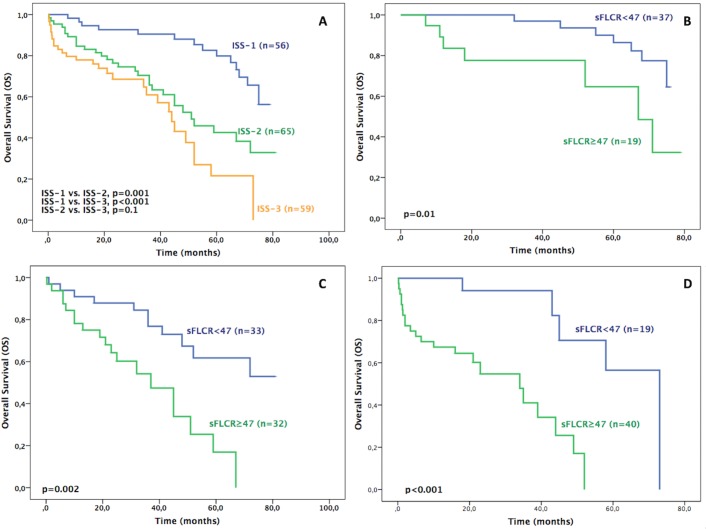
A) Overall Survival (OS) of all patients based on International Staging System (ISS) (n = 180). B) OS of patients in ISS-1 stratified by sFLCR (n = 56). C) OS of patients in ISS-2 stratified by sFLCR (n = 65). D) OS of patients in ISS-3 stratified by sFLCR (n = 59).